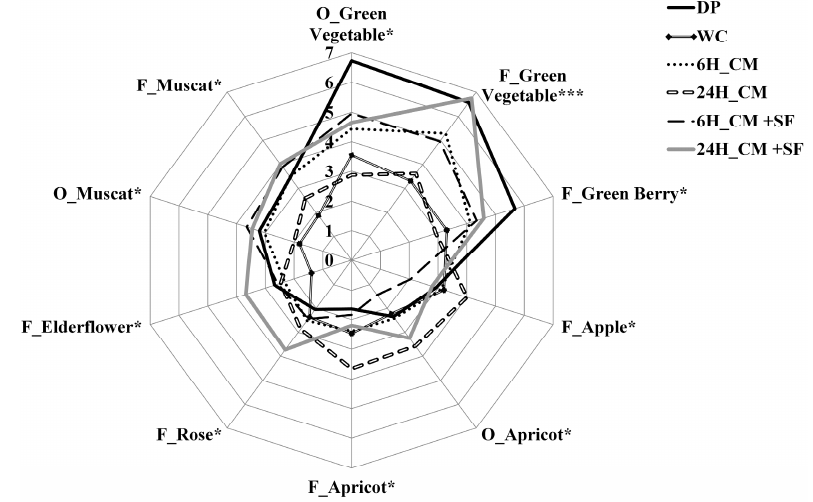
Figure 1. Sensory profile of six wines produced from different pre-fermentation procedures;